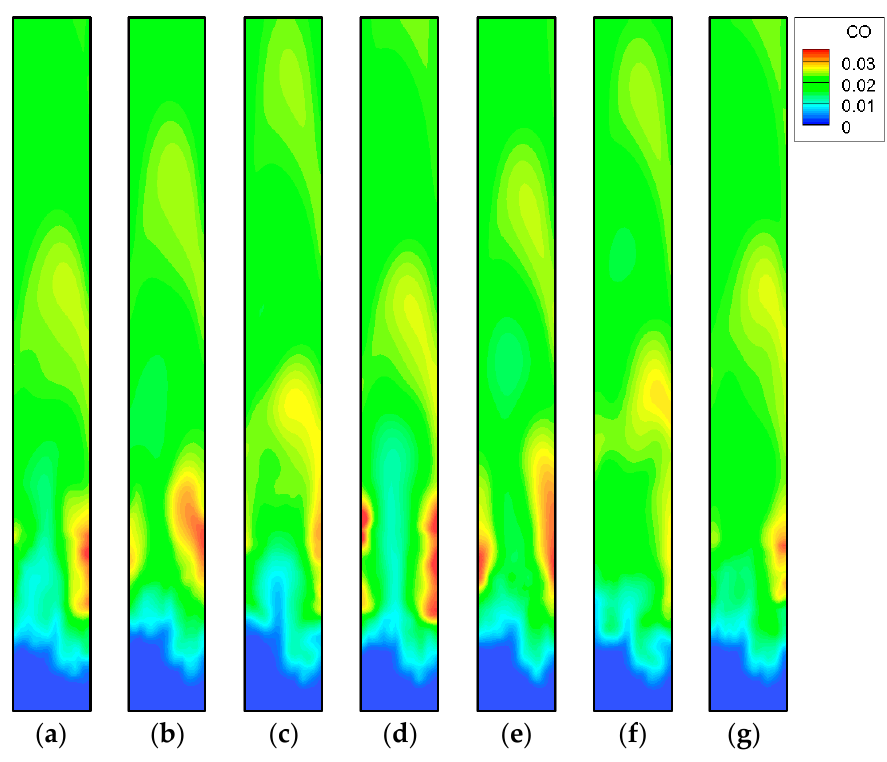
Figure 5. Temperature distributions. ( a ) 9 s, ( b ) 9.1 s, ( c ) 9.2 s, ( d ) 9.3 s, ( e ) 9.4 s, ( f ) 9.5 s, and ( g ) 9.6 s.